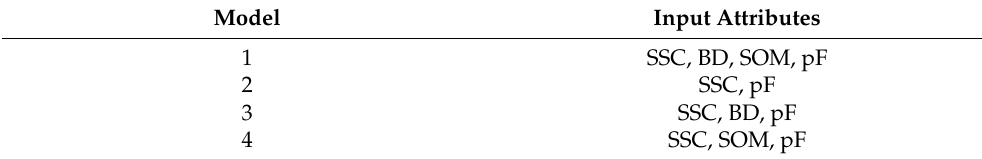
Table 2. Combinations of input attributes used in this study to develop PC NN -PTFs. Model